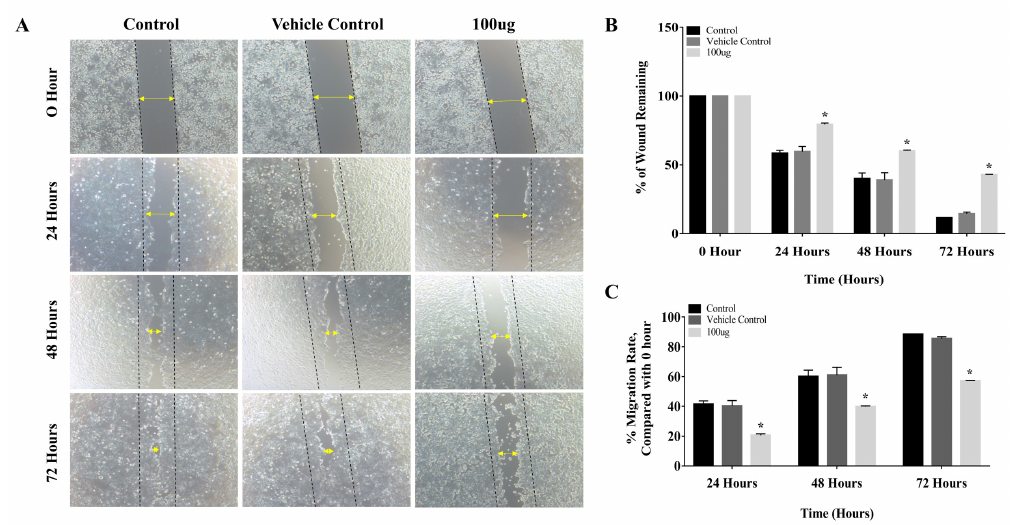
Figure 3. Inhibitory effect of L. barbarum extract on cell migration: (A) Treatment with L. barbarum signifi- cantly inhibited the migration of CAL-27 cells. At a concentration of 100 μ g, a reduction in cell migration and an increase in the percentage of wound remaining were observed. At the end of 72 hours, the percentage of wounds remaining was 42.8% in the treated group whereas, in the untreated group, it was 11.5%. (B) and (C)RepresentativeBargraphsdepicting thepercentageof woundsremaining andpercentagemigration rate at the given time